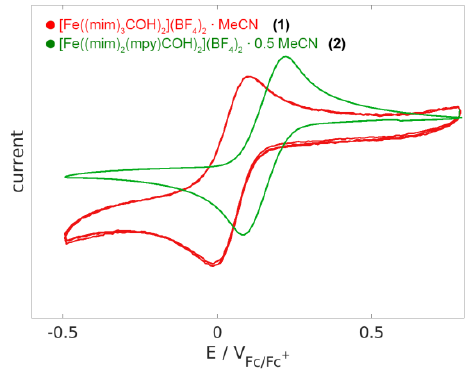
Figure 9. Cyclic voltammograms of 1 ( red ) and 2 ( green ).